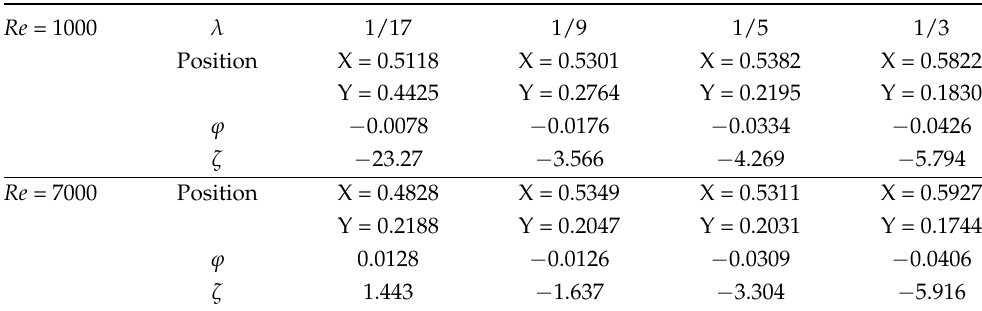
Table 4. Vortex properties of the primary vortex of different geometries at steady Reynolds numbers 1000 and